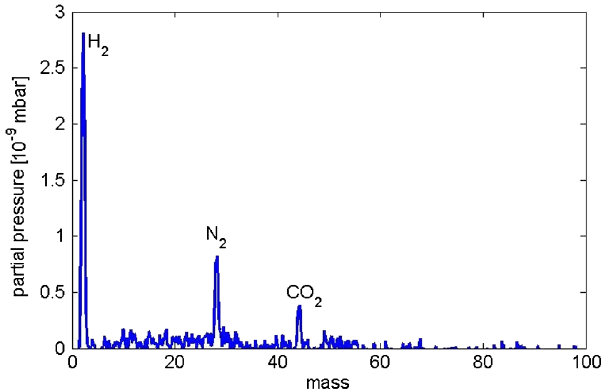
FIG. 8. RGA scan of the structure after brazing.